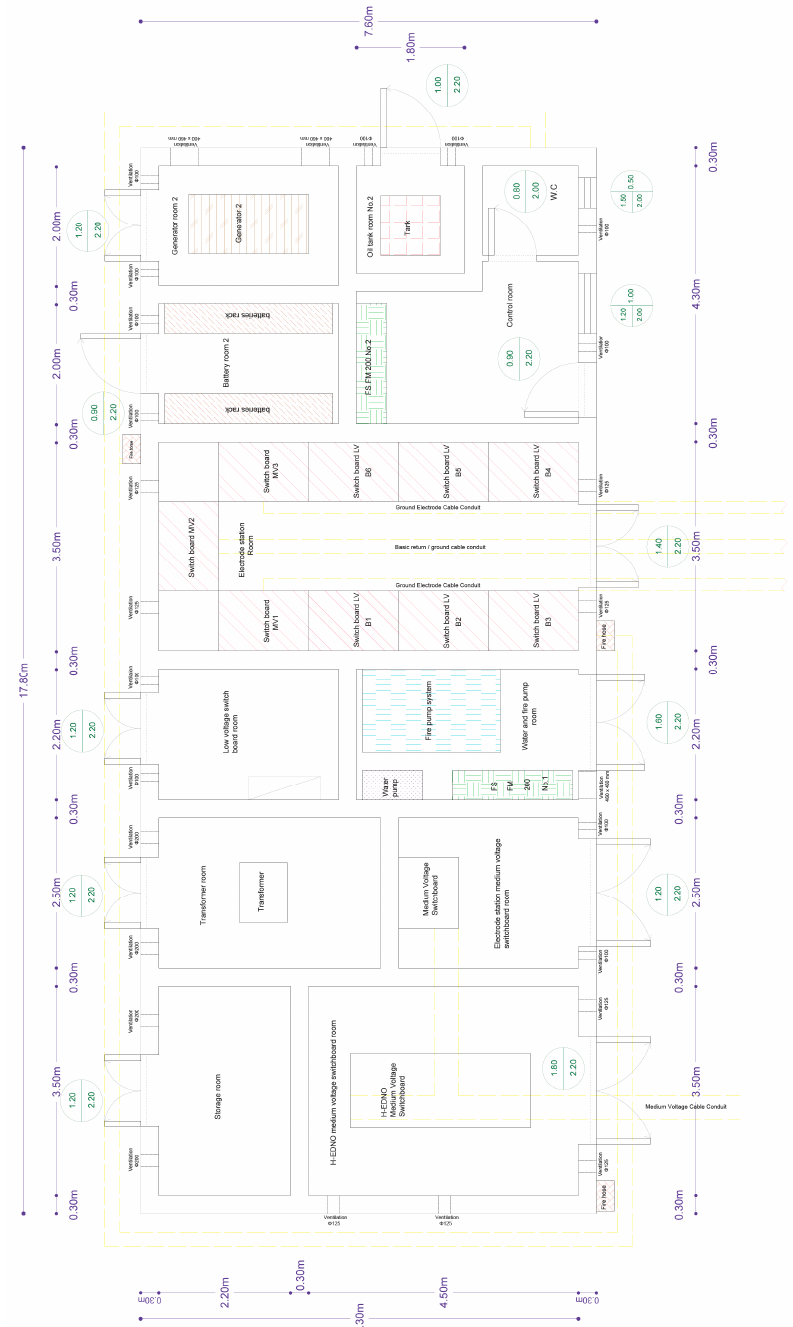
Figure 5. Layout of the electrode station building in Stachtoroi, Saronic Gulf, Attica in case of connection with the distribution network.